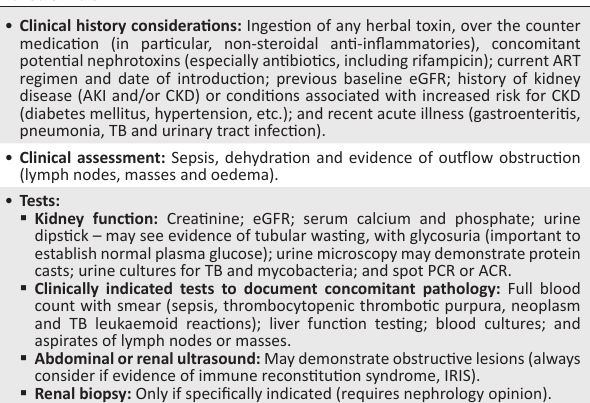
• Tests: ß Kidney function: Creatinine; eGFR; serum calcium and phosphate; urine dipstick – may see evidence of tubular wasting, with glycosuria (important to establish normal plasma glucose); urine microscopy may demonstrate protein casts; urine cultures for TB and mycobacteria; and spot PCR or ACR. ß Clinically indicated tests to document concomitant pathology: Full blood count with smear (sepsis, thrombocytopenic thrombotic purpura, neoplasm and TB leukaemoid reactions); liver function testing; blood cultures; and aspirates of lymph nodes or masses. ß Abdominal or renal ultrasound: May demonstrate obstructive lesions (always consider if evidence of immune reconstitution syndrome, IRIS). ß Renal biopsy: Only if specifically indicated (requires nephrology